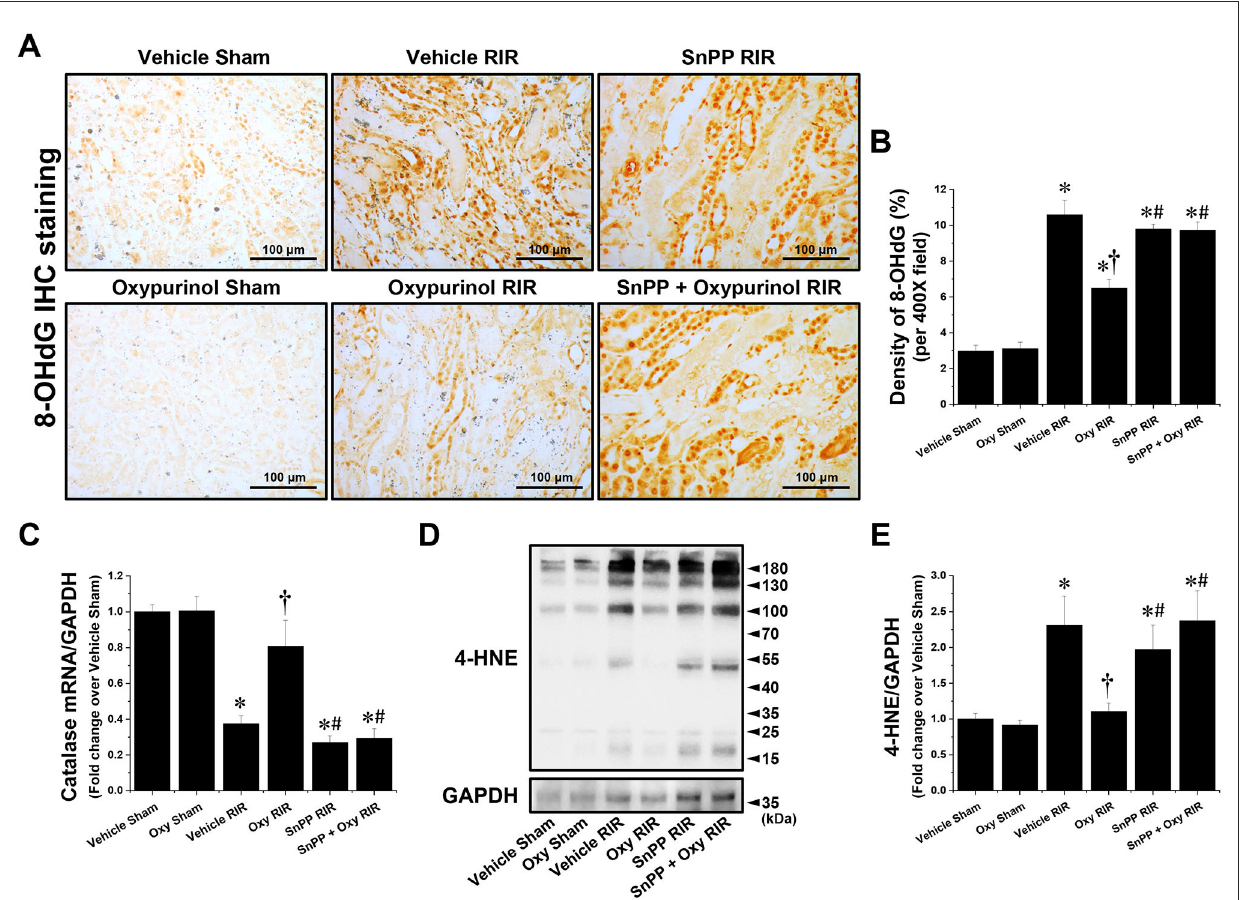
FIGURE4 Oxypurinol reduces oxidative damage after renal ischemia/reperfusion injury. C57BL/6 male mice were subjected to sham or 30min of renal ischemia surgeries. Some mice were pretreated with 25 mg/kg of oxypurinol 24h and 1h preoperatively. Separate cohorts of mice were injected with tin protoporphyrin IX [SnPP, a heme oxygenase-1 (HO-1) inhibitor, 25 mg/kg, Tocris Bioscience] 30min before oxypurinol treatment. (A) Representative images (magnification, 400 × ) of 8-OHdG (dark brown) show immunohistochemistry staining in the post-operative kidneys. (B) Densities of 8-OHdG staining were measured using the Fiji Image J2 software as described. (C) With quantitative RT-PCR, we measured the mRNA expression of catalase, an antioxidant enzyme. Catalase mRNA expression was normalized to GAPDH mRNA expression. (D) Kidney samples were subjected to Western blotting using an anti-4-Hydroxynonenal (4-HNE) antibody. GAPDH was used as a loading control. (E) Band intensities were measured using the ImageJ software. Results are expressed as means ± SEM (vehicle or oxypurinol [oxy] sham n = 4; vehicle, oxypurinol, SnPP, or SnPP + oxypurinol RIR n = 6). * P < 0.05 vs. vehicle sham; † P < 0.05 vs. vehicle RIR; # P < 0.05 vs. oxypurinol